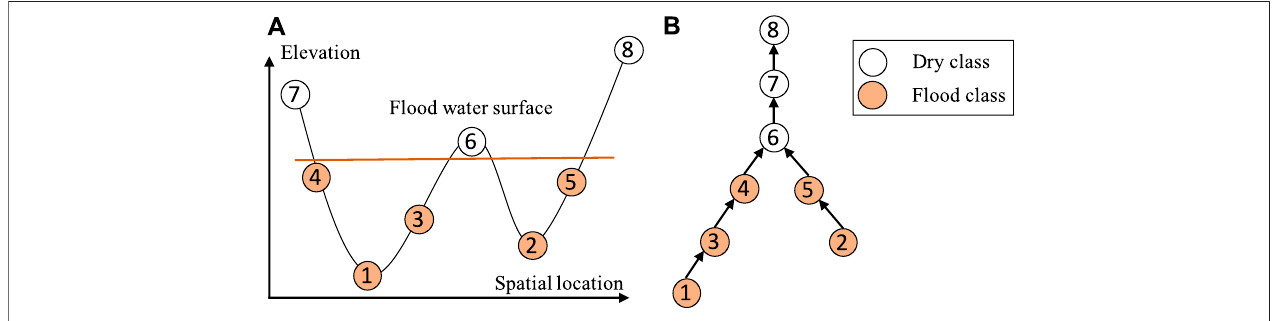
FIGURE 2 | Illustration of partial order class dependency (A) Eight consecutive locations in 1D space (B) Partial order constraint in a reverse tree.